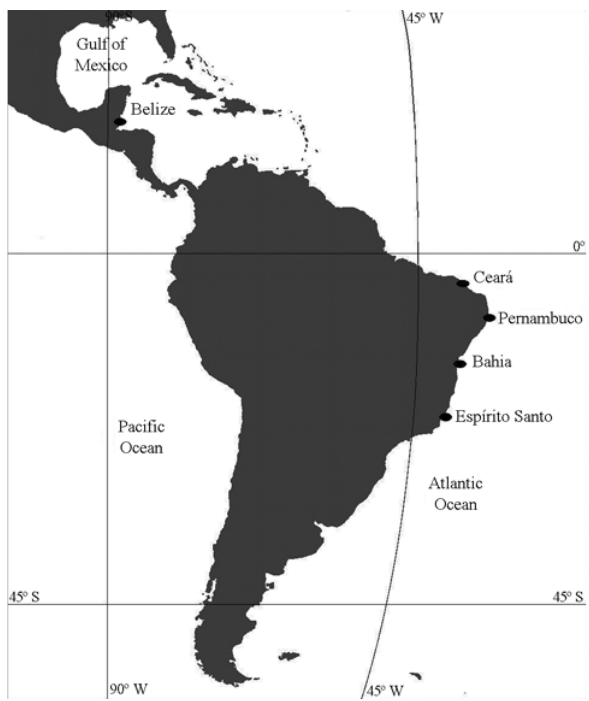
Figure 1 - Collection localities of Ocyurus chrysuru s.